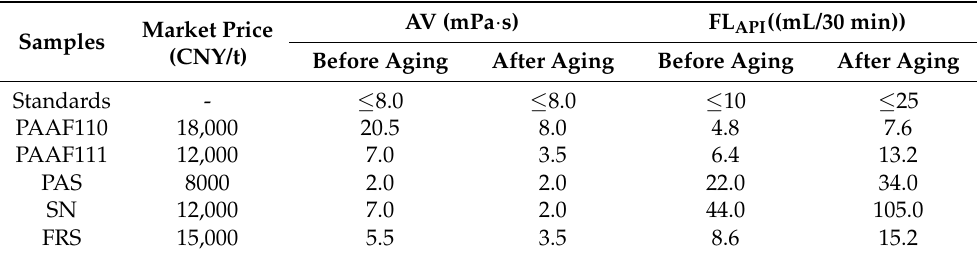
Table 7. Market price and performance comparison of the fluid loss reducer products.